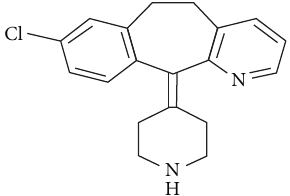
Figure 1: Desloratadine structure.